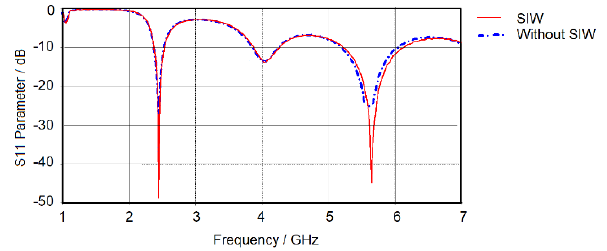
FIGURE 6. S11 Parameter of Vivaldi antenna with and without SIW structure.